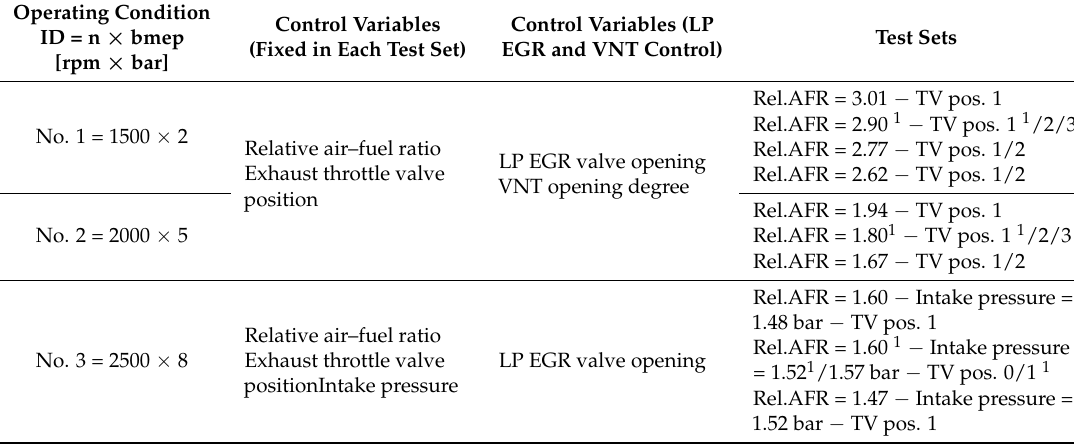
Table 4. Schedule of experimental activities (HP EGR + Low Pressure (LP) EGR + Variable Nozzle Turbine (VNT) control) [17].